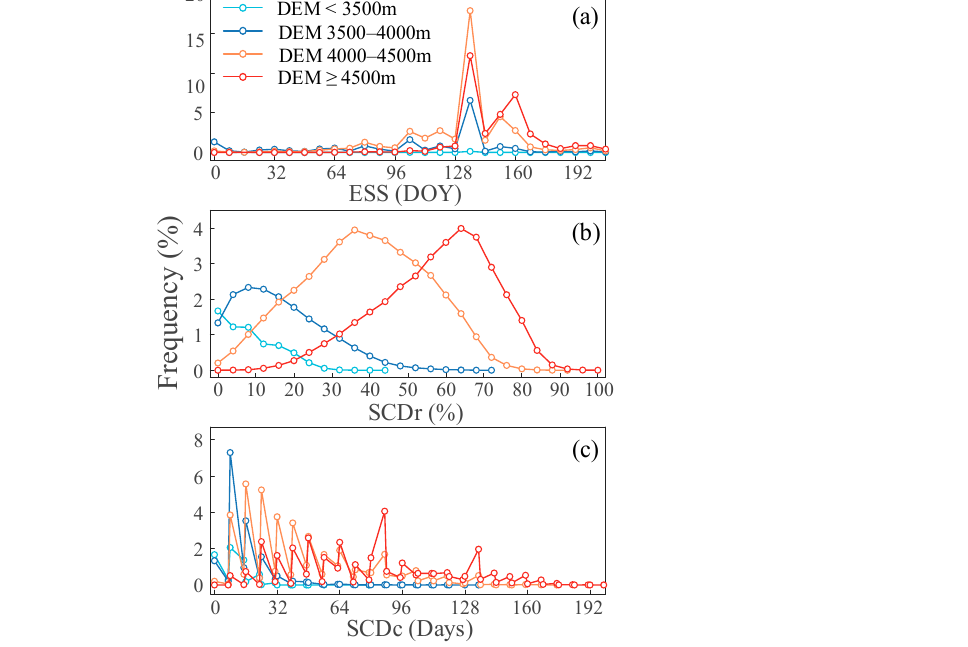
Figure 7. Statistical distributions of ( a ) ESS, ( b ) SCDr, and ( c ) SCDc in each elevation zone.